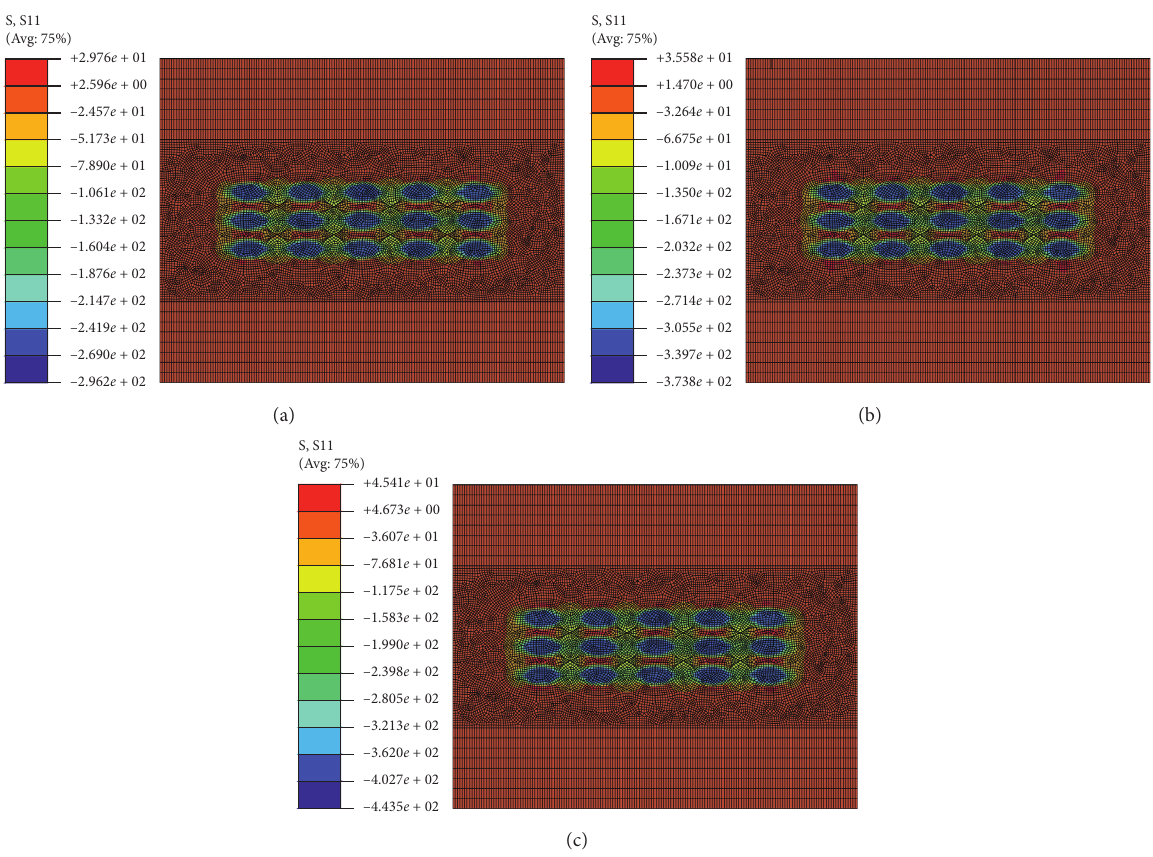
Figure 6: Contours of residual stress distribution of sample surface with different laser power. (a) 5J, (b) 6 J, and (c) 7J.